Question: Briefly state, in one sentence, what is plotted here.
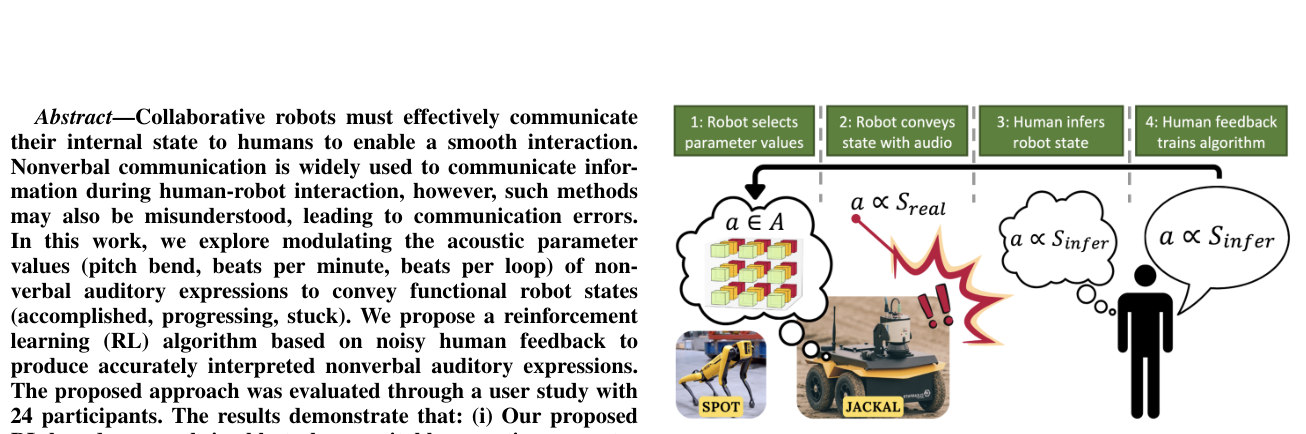
Answer: A robot nicknamed Jackal learning to generate nonverbal expressions to be correctly understood by users. The robot state perceived by the human is used to generate feedback to train the learning algorithm. The Spot robot image used within our user study procedure is also shown for reference.